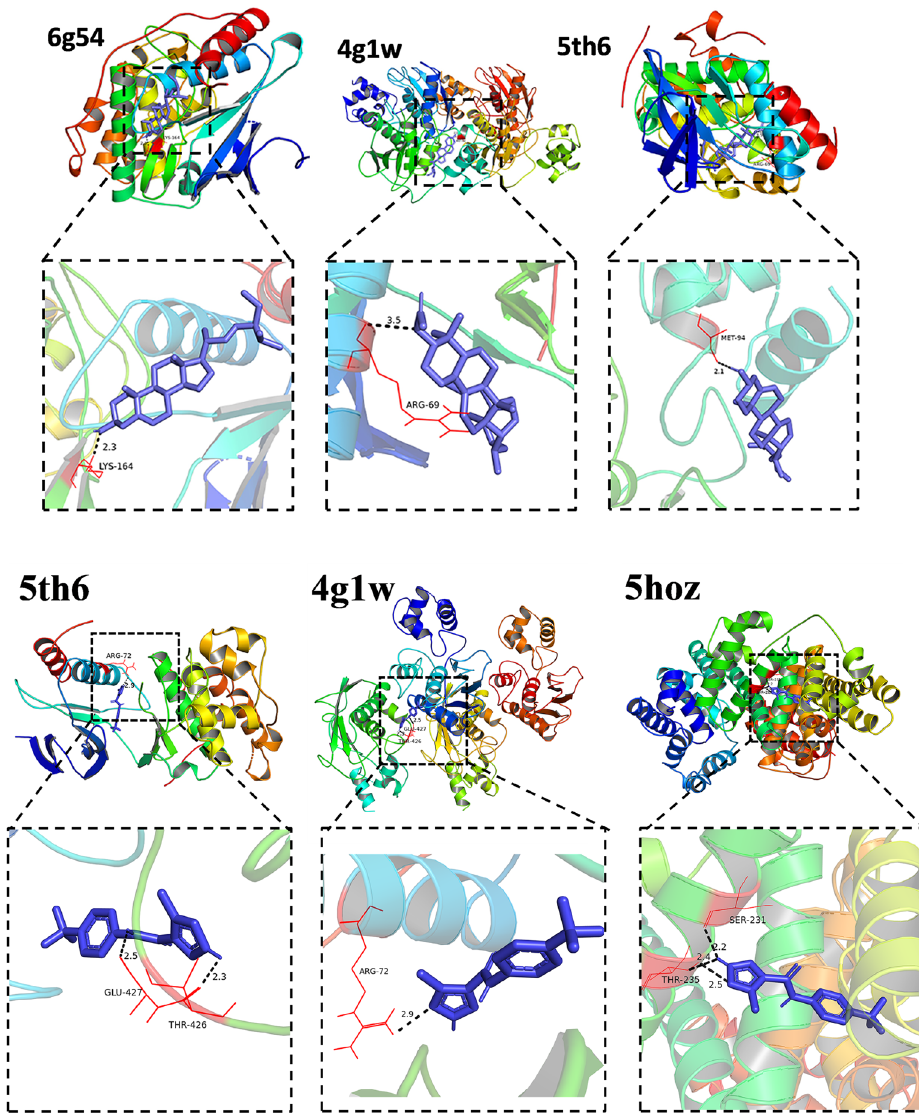
Figure 6. The docking posture and interactions between Strigmasterol and 6G54, Cycloartenol Acetate and 4G1W, Dammaradienyl acetate and 5TH6, Leflunomide and 5th6, Leflunomide and 4g1w, Leflunomide and